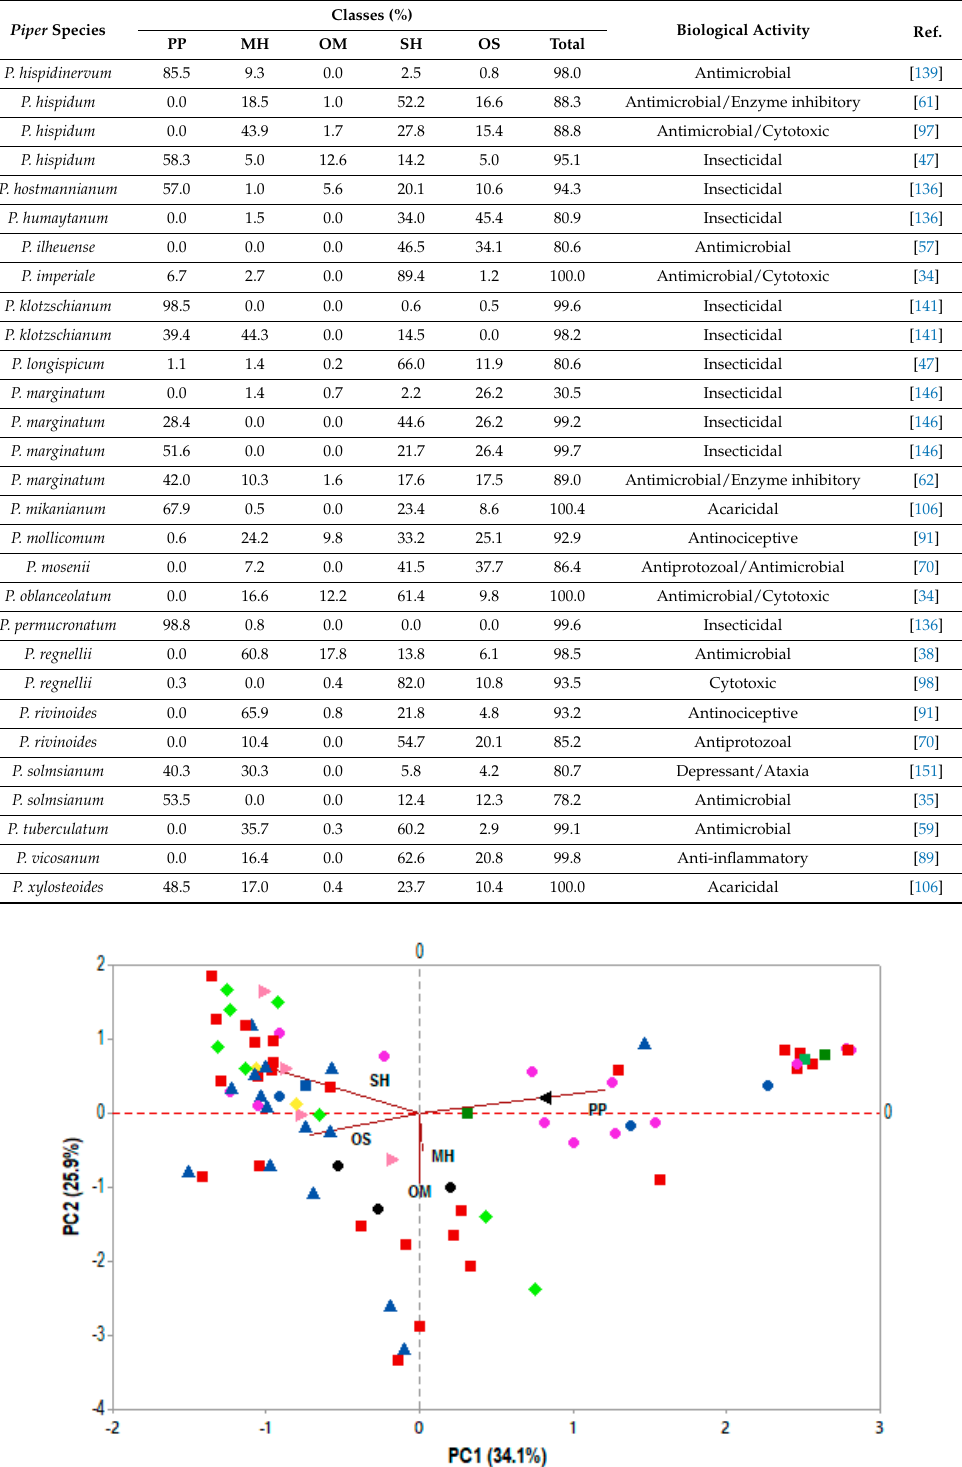
Figure A5. ■ : Antimicrobial (fungal and bactericidal), ♦ : Cytotoxic activity, ▲ : Antiprotozoal ( Trypanosoma spp. and Leishmania spp. ), ● : Inseticidal ( Aedes aegypti ), ■ : Acaricidal, ♦ : Anti-inflammatory; ● : Anticholinesterase, ● : Antinociceptive, ■ : Central nervous system depressant, ► : Antimicrobial and cytotoxic, ◄ : Fungicidal and Anticholinesterase.